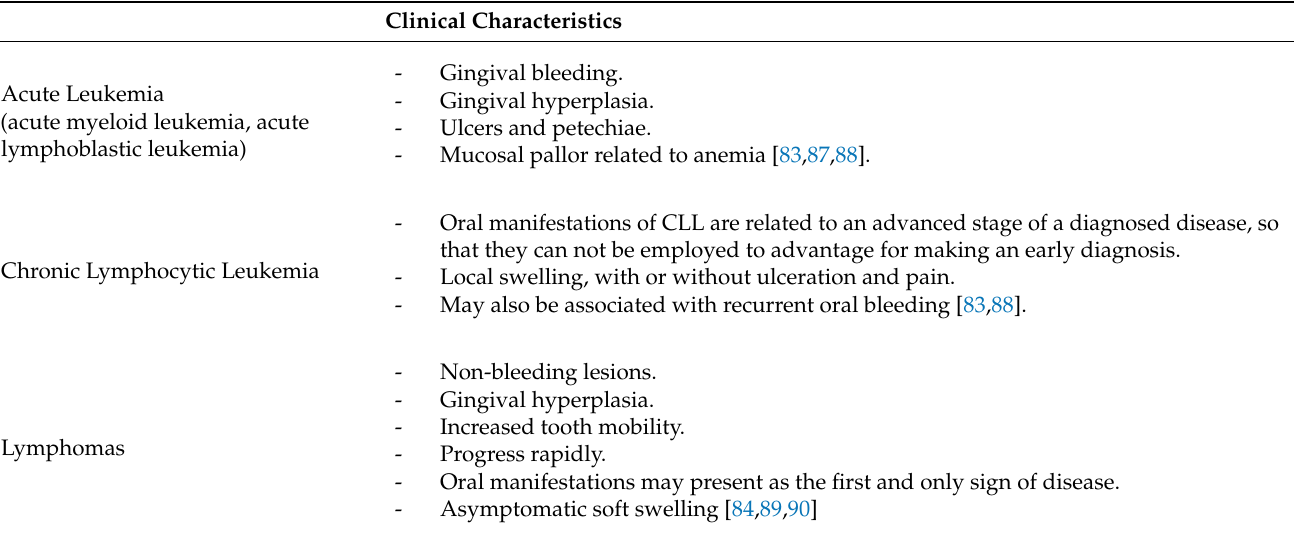
Table 3. Clinical characteristics of leukemias and lymphomas related gingival overgrowth. Clinical